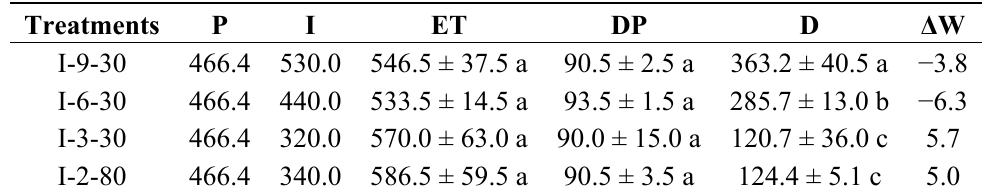
Table 4. Water balance components (mm). P = precipitation, I = irrigation amount, ET = evapotranspiration, DP = deep percolation, D = discharge amount, Δ W = change of field surface water depth. Means in the same column followed by the same letter are not significantly different at the 0.05